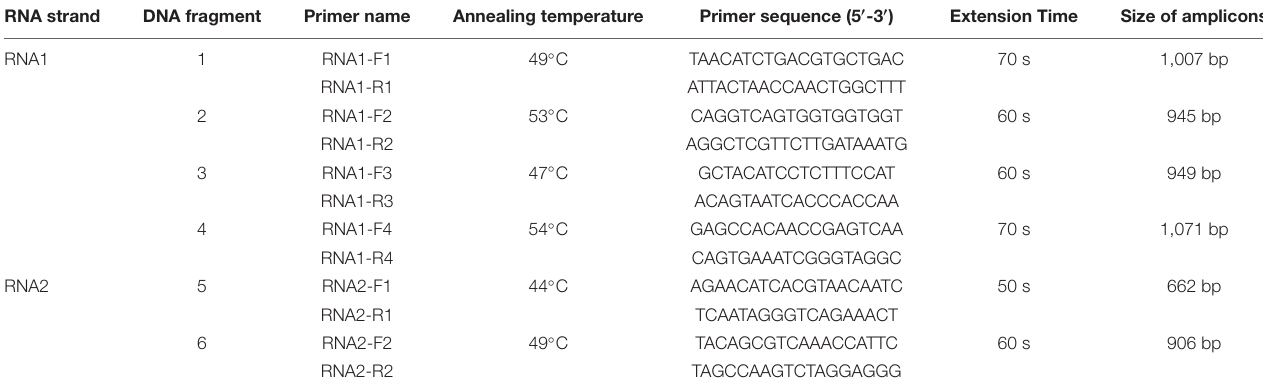
FIGURE 2 | Prevalence of covert mortality nodavirus (CMNV) in Larimichthys polyactis of the Yellow Sea and the East China Sea in 2018 and 2019. (A) Pattern line drawing of L. polyactis ; (B) CMNV-positive rates of samples and sampling sites; (C) prevalence rate and prevalence scope of CMNV. The black solid circles indicated the sites that L. polyactis were collected. The red solid circles indicate the sites the CMNV-positive L. polyactis were collected. The sizes of red solid circles represent the CMNV-positive rates. TABLE 1 | PCR primer’s sequence, annealing temperature, and extension duration used to amplify RNA1 and RNA2 of covert mortality nodavirus (CMNV). RNA strand DNA fragment Primer